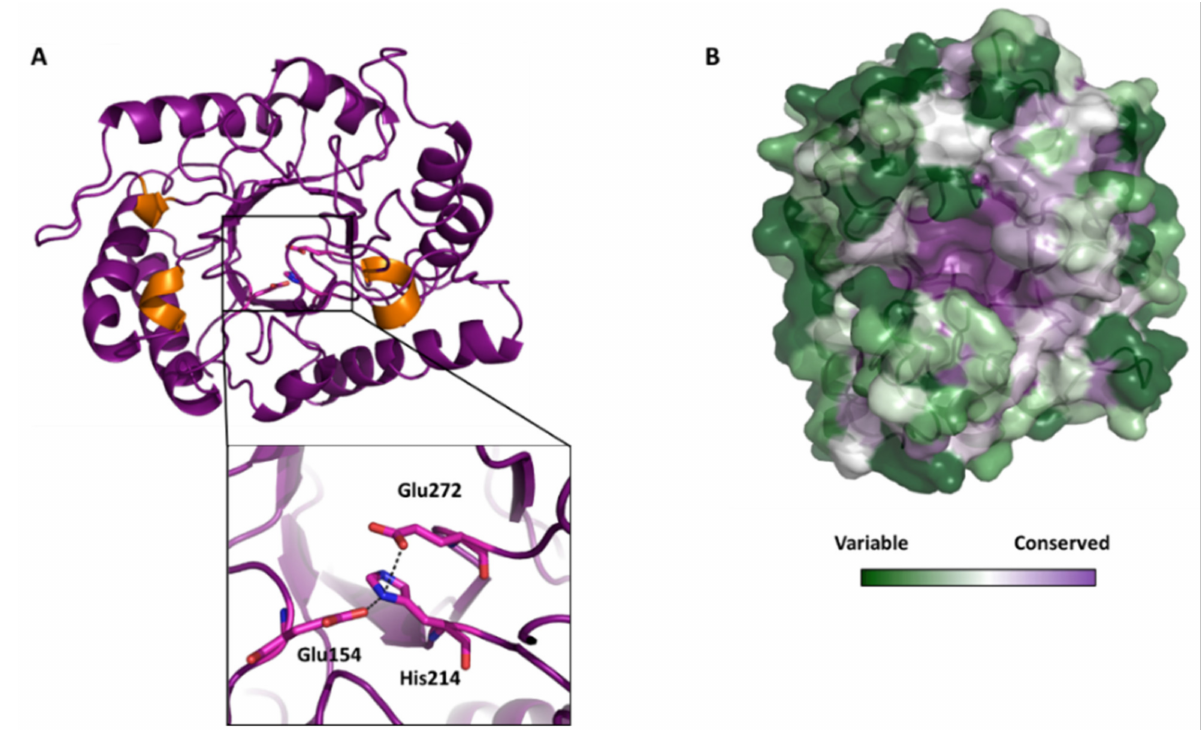
Figure 3. Crystal structure of DtCel5A. ( A ) Cartoon representation of DtCel5A, where the inset shows the location of catalytic residues. ( B ) ConSurf analysis, showing most conserved regions of the protein surface (prune); the color code for sequence conservation is